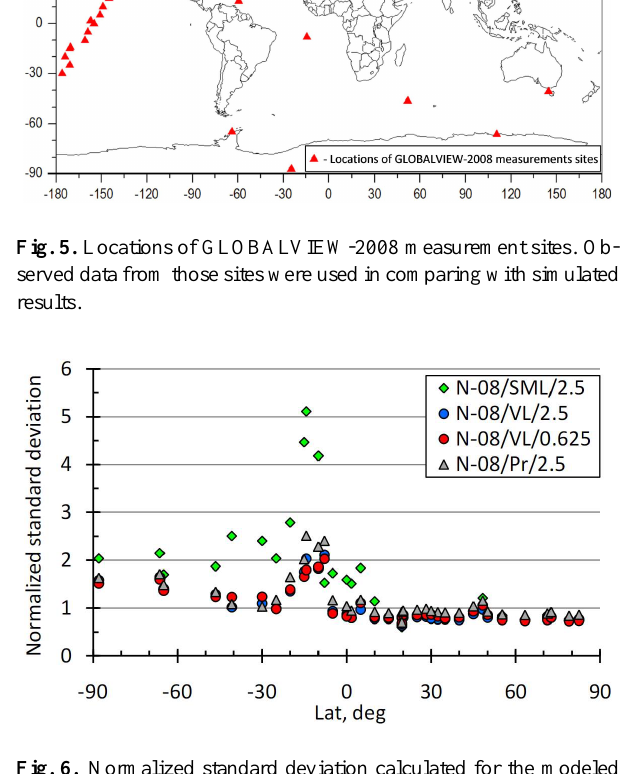
Fig. 6. Normalized standard deviation calculated for the modeled and observed patterns of CO 2 for 2008.